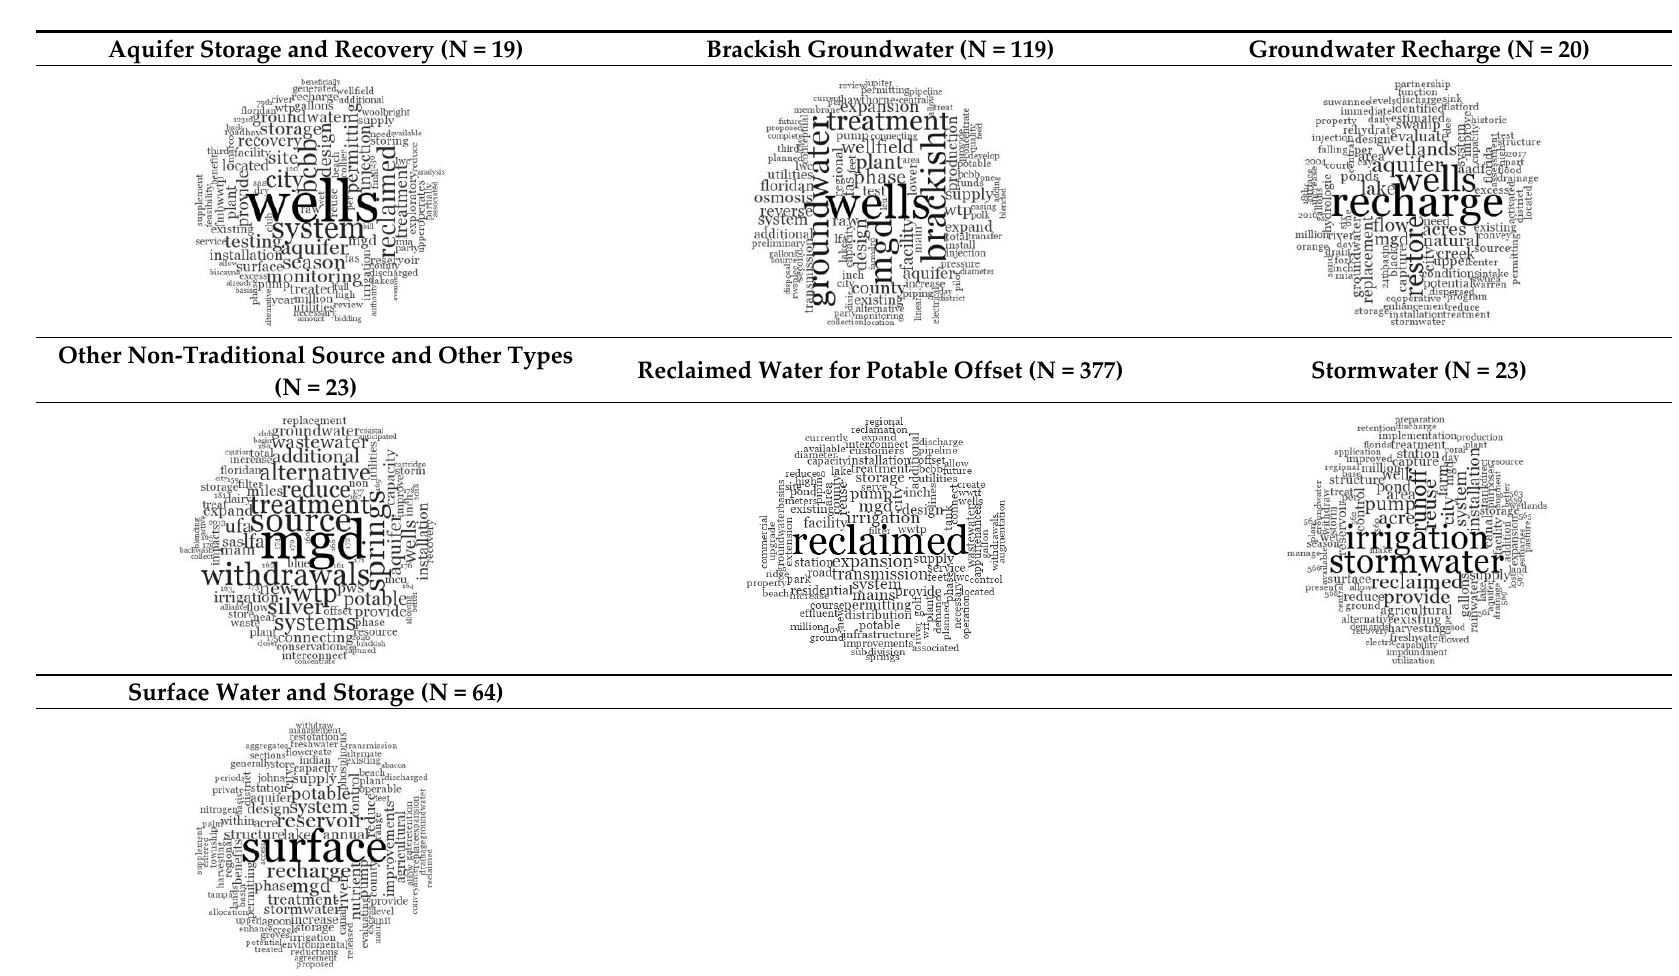
Figure 3. Project description: WordCloud summary, by project type (100 most common words; created in NVivo Software, version 12, using “with stemmed words” option).